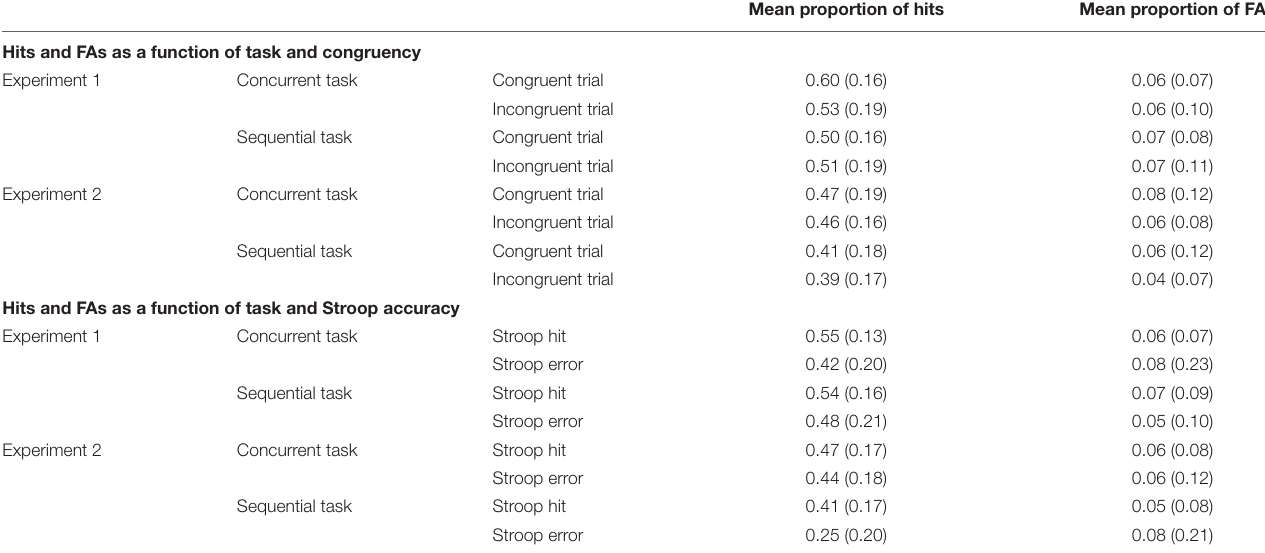
TABLE 2 | Mean proportion of hits and FA (with standard deviations in parentheses) for congruent and incongruent trials in Experiment 1 (high proportion congruent) and Experiment 2 (low proportion congruent), and for Stroop hits and Stroop errors in both experiments.